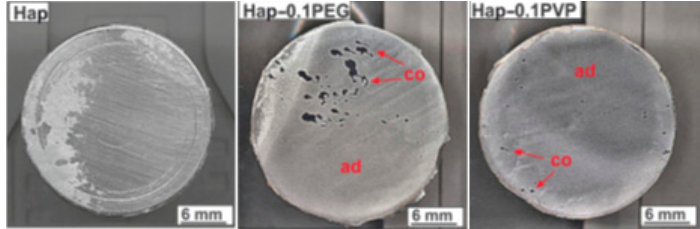
Figure 9. Surface of the coated samples and the detached coatings after adhesion strength tests [136].